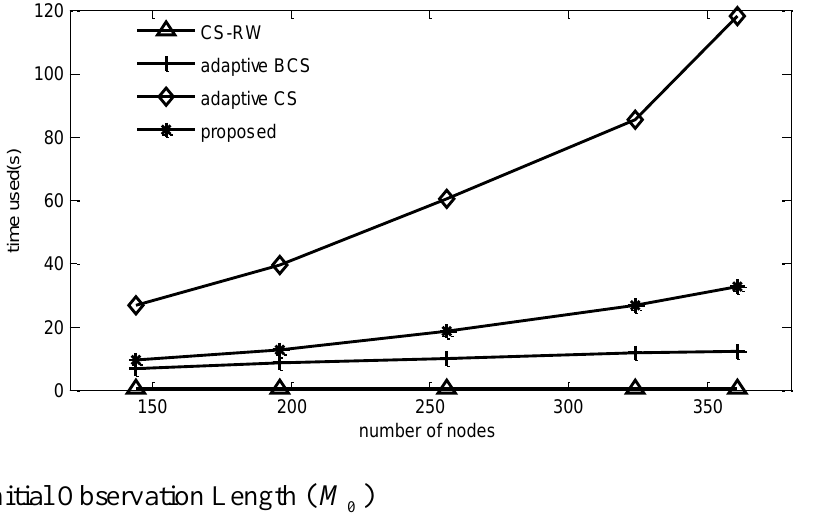
Figure 11. Computation complexity vs. number of